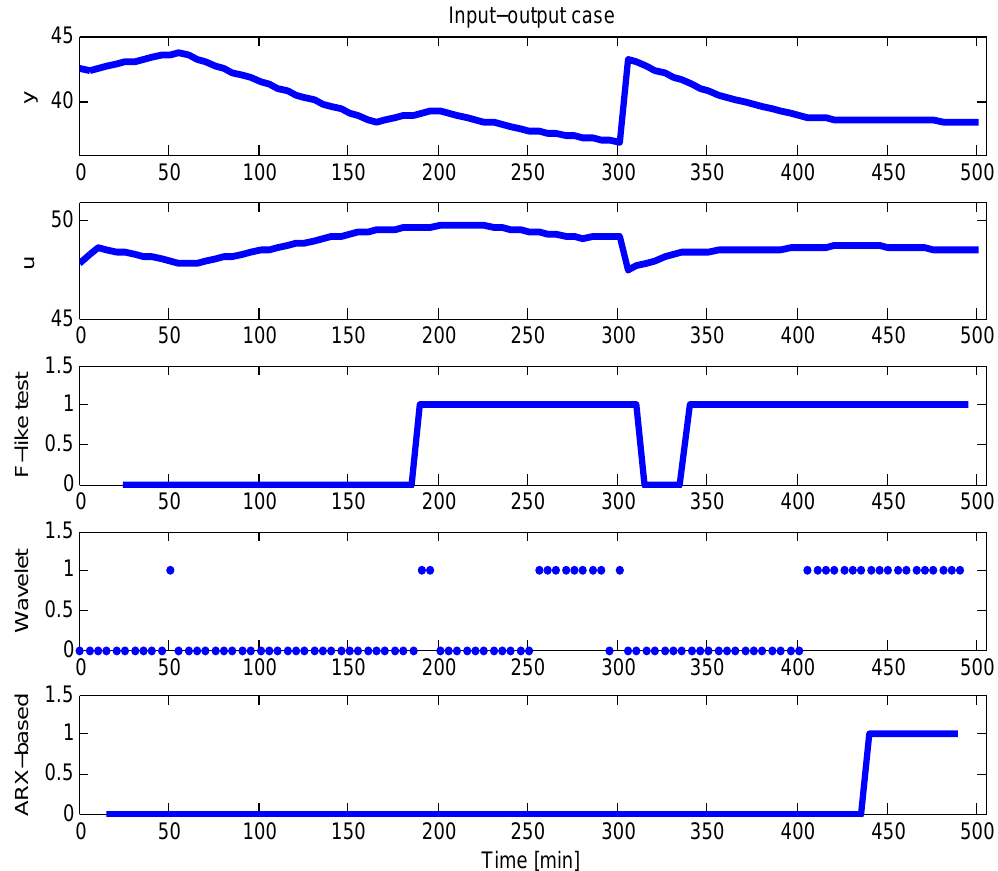
Figure 19. HX4 input-output case with a measurement frequency of 5